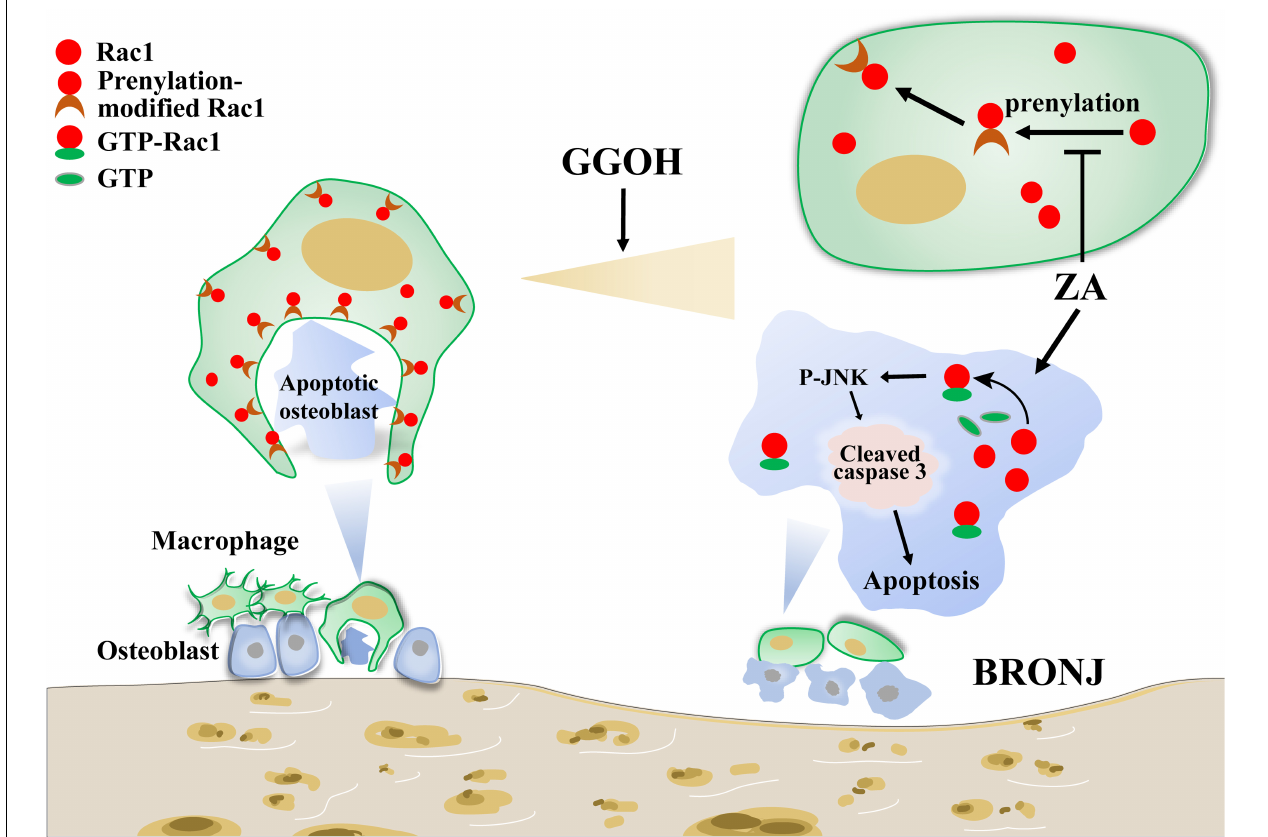
FIGURE 5 | Working model of ZA in inducing osteocytic apoptosis of BRONJ. On the one hand, ZA could overactivate Rac1 to stimulate JNK phosphorylation, leading to cell apoptosis. On the other hand, ZA inhibits Rac1 membrane translocation, causing difficulty in macrophage morphological deformation and efferocytosis. Supplement of GGOH, a neutralization drug against ZA-disturbed Rac1 status, could restore macrophage efferocytosis and prevent osteocytic apoptosis in the development of BRONJ. ZA, zoledronic acid; BRONJ, bisphosphonate-related osteonecrosis of the